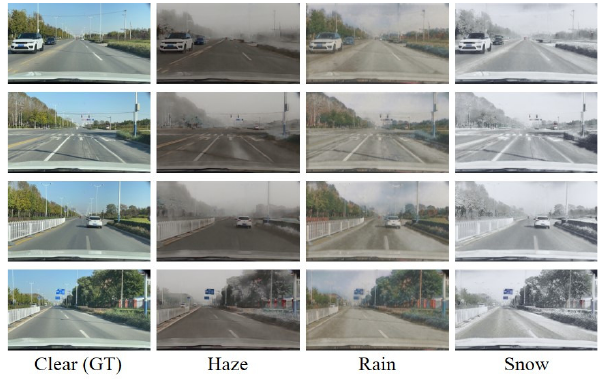
Figure 5. Weather generation results for RDSBW. Even when trained without paired image sets, MWTG still can translate clear images into images of our three adverse weather conditions without corrupting the background context.